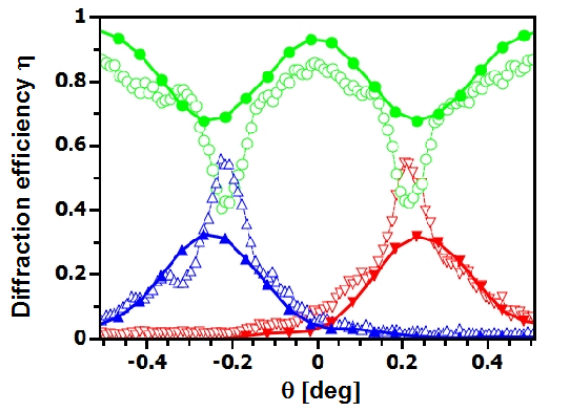
Figure 6. Rocking curves measured at λ ≈ 4 . 4 nm for zero tilt ( N · · · − 1 st order, l . . . 0 th order, H · · · + 1 st order) and ζ = 68 ◦ ( △ · · · − 1 st order, # . . . 0 th order, order). Grating parameters: Λ = 0 . 5 µ m, d of the tilted peaks toward θ = 0 and their unexpectedly low η wavelength distribution, as simulations